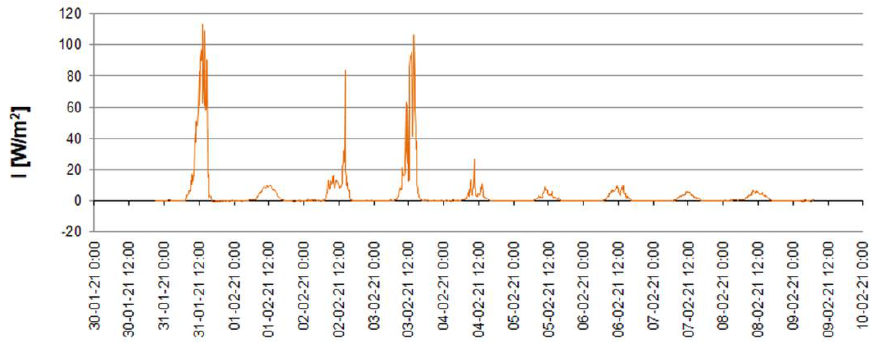
Figure 2. Global solar irradiance on the west-facing wall during measurements.